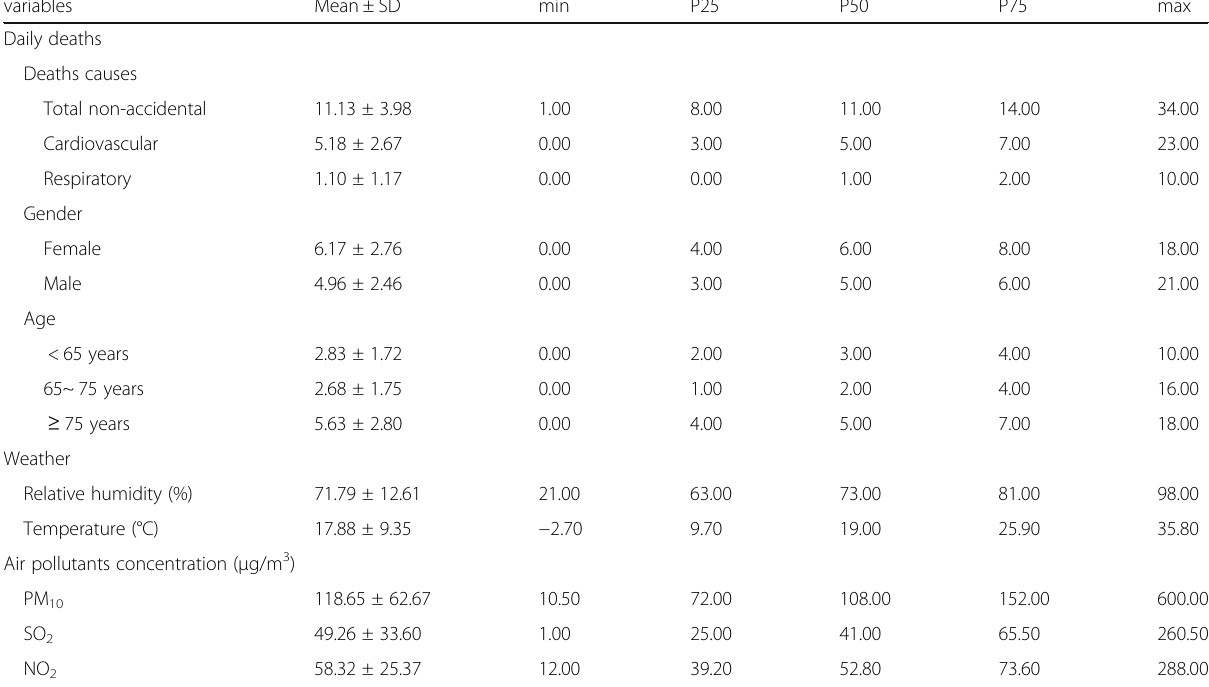
Table 1 Summary statistics of daily deaths, air pollution concentrations and atmosphere variables in Wuhan, China, from 2002 to